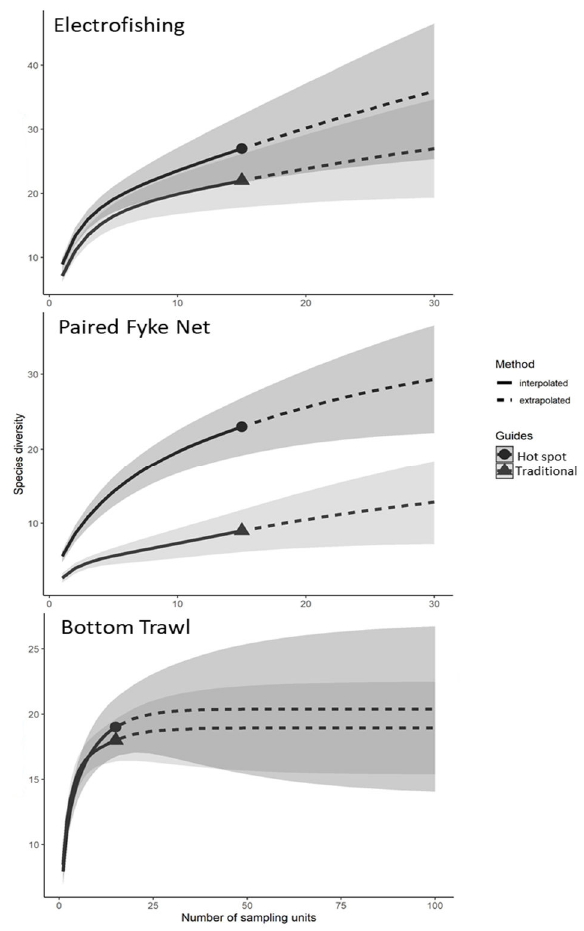
Figure 2. Species accumulation curves for sampling gears at Maumee Bay in 2017. The triangle symbol indicates the species accumulation curve for traditional sampling sites ( n = 15), while the circle symbol indicates the species accumulation curve for combined hot spot ( n = 5) and selected traditional ( n = 10) sampling sites. The solid lines represent the interpolated data while the dashed lines represent the extrapolated data. The shaded areas show 95% confidence intervals for each line.